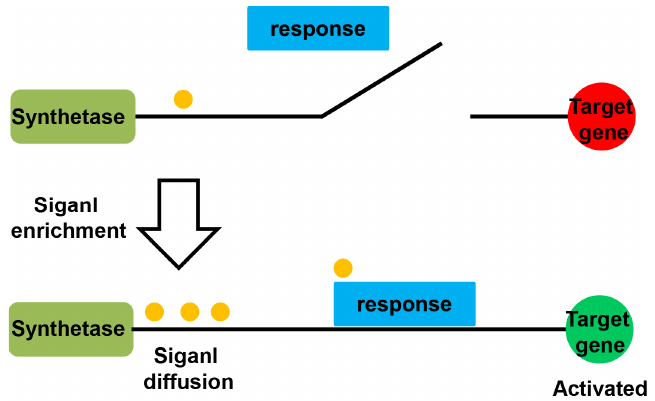
Figure 1. The quorum sensing pathway.